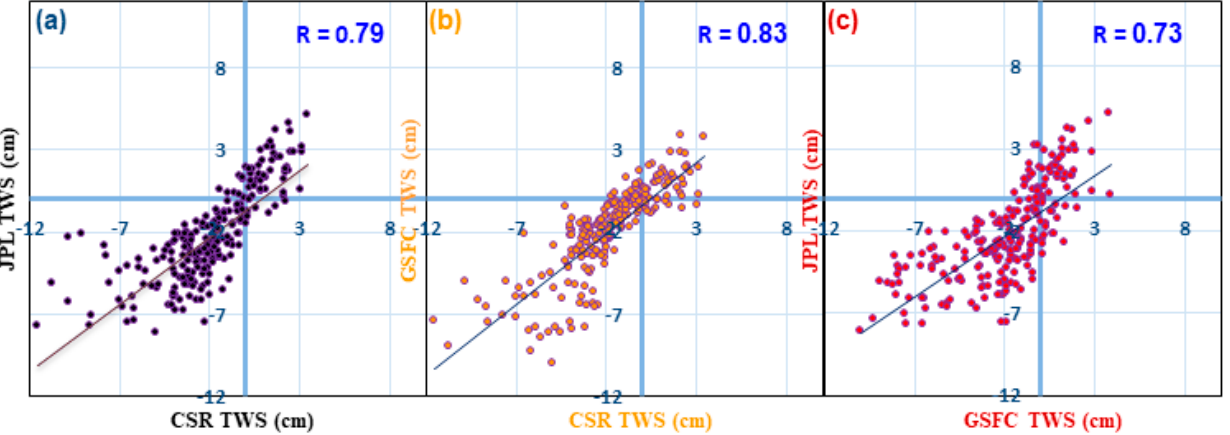
Figure 7. Correlation coe ffi cient (R) between Δ TWS data from the averaging of JPL and CSR mascon solutions ( a ); GSFC and CSR mascon solutions ( b ); and JPL and GSFC mascon solutions ( c ) over the wadi region.